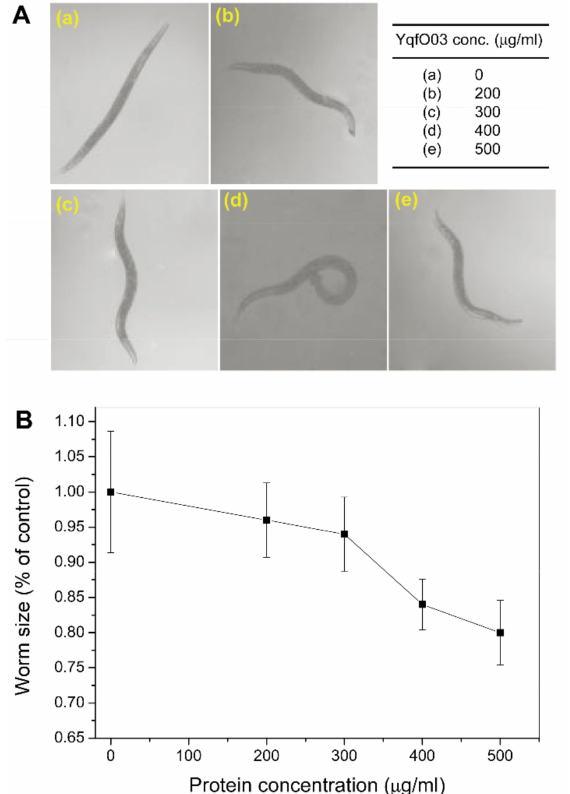
Figure 6. Growth assay of L 1 larvae of C. elegans with YqfO03 protein treatment. ( A ) Wild-type L 1 worms were cultured in gradient doses of the YqfO03 protein in a concentration range of 0–500 µ g/mL, were incubated at 20 ◦ C for 60 h, and then were photographed using a light microscope. ( B ) The size of worms cultured in 0–500 µ g/mL of the YqfO03 protein as a percentage of the size of worms cultured in the absence of the YqfO03 protein. The average size of worm was calculated using the software NIH Image J 1.3. Data represent the averages of 20 measurements at each protein concentration. Error bars represent standard